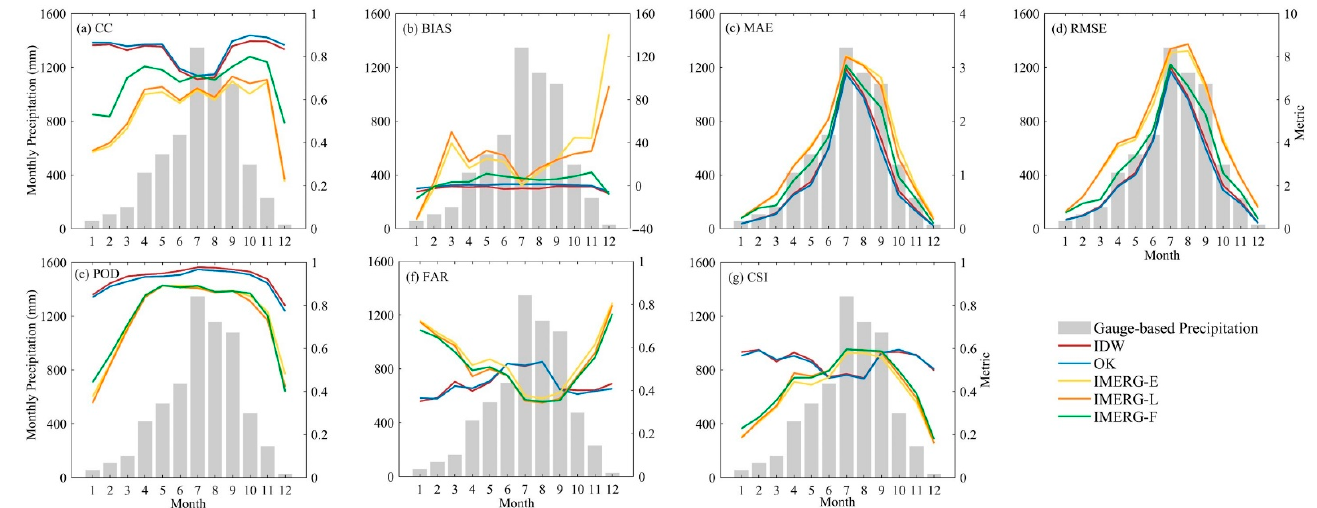
Figure 5. Monthly precipitation in MRYRB and monthly variations of statistical metrics calculated by daily precipitation. The gray columns in the left axis demonstrate the monthly precipitation.